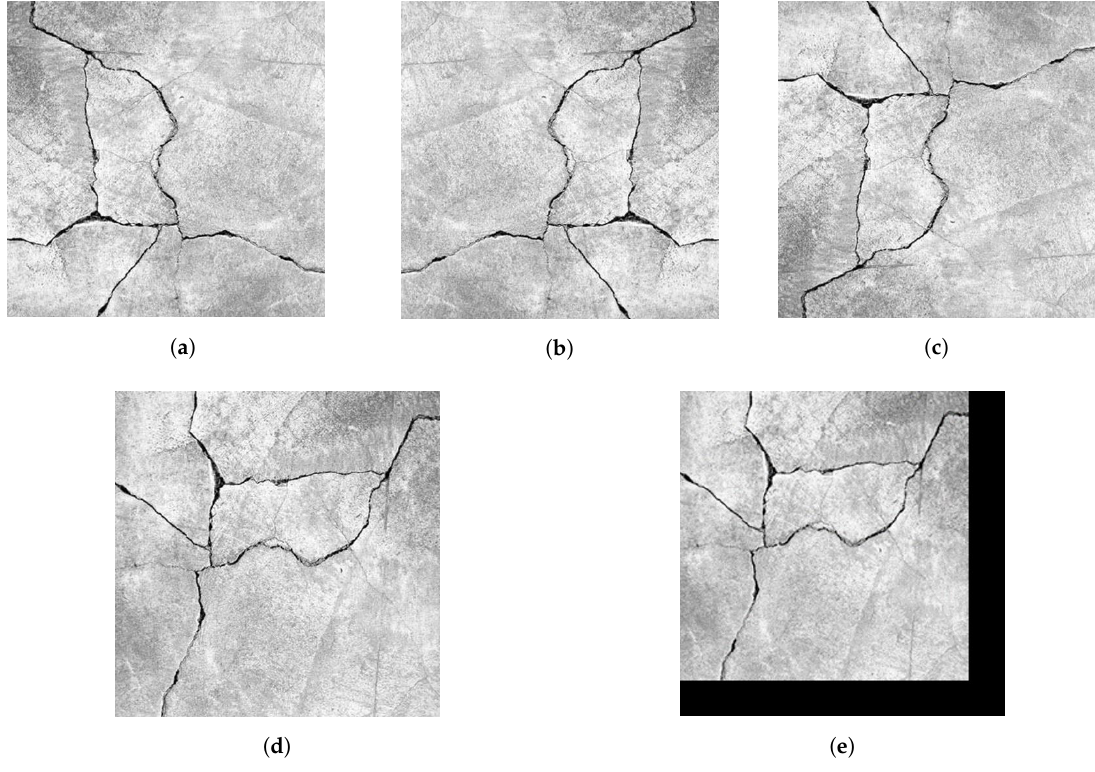
Figure 4. Examples of image augmentation: ( a ) original image of crack, ( b ) flipping left-right, ( c ) flipping up-down, ( d ) rotating 90 ° , and ( e ) zero padding at right and bottom